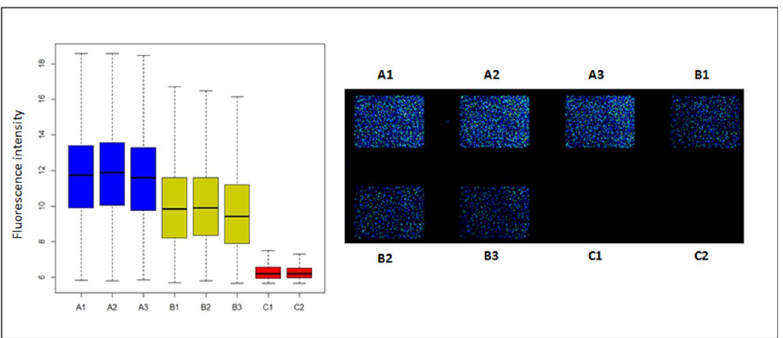
Fig 3. Fluorescence signal of hybridization conditions on the microarray represented in boxplot (left) and the microarray slide (right). Control group (A1, A2 and A3 in both cases) corresponds to the three experimental replicates of planktonic Porphyromonas gingivalis ATCC 33277. Test group (B1, B2 and B3 in both cases) represents the multispecies biofilm including P . gingivalis . And the negative control group (C1 and C2 in both cases) shows the multispecies-biofilm without P . gingivalis